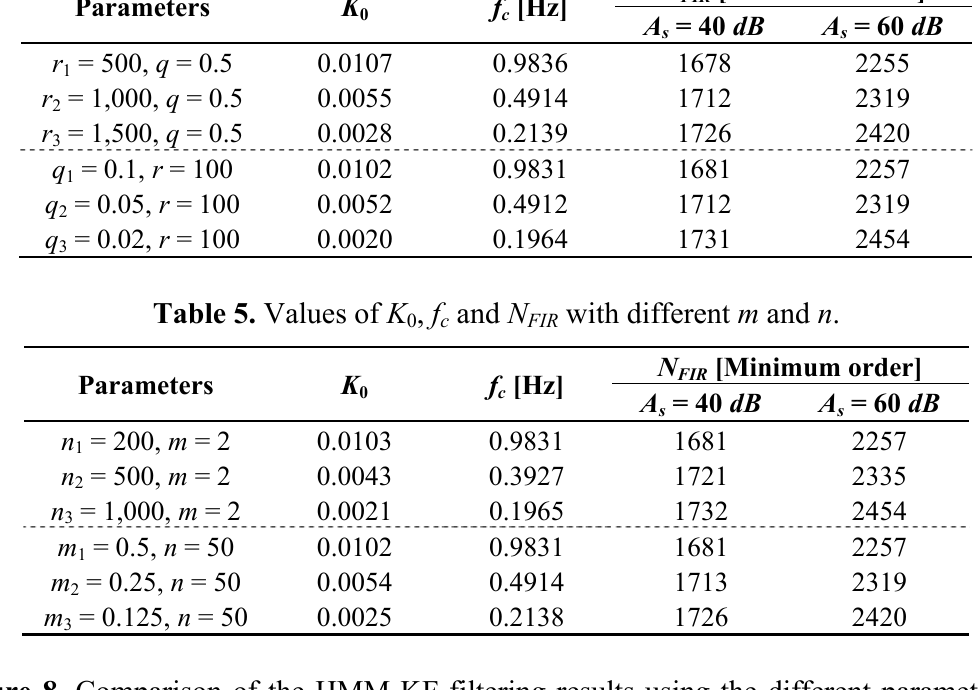
Table 4. Values of K